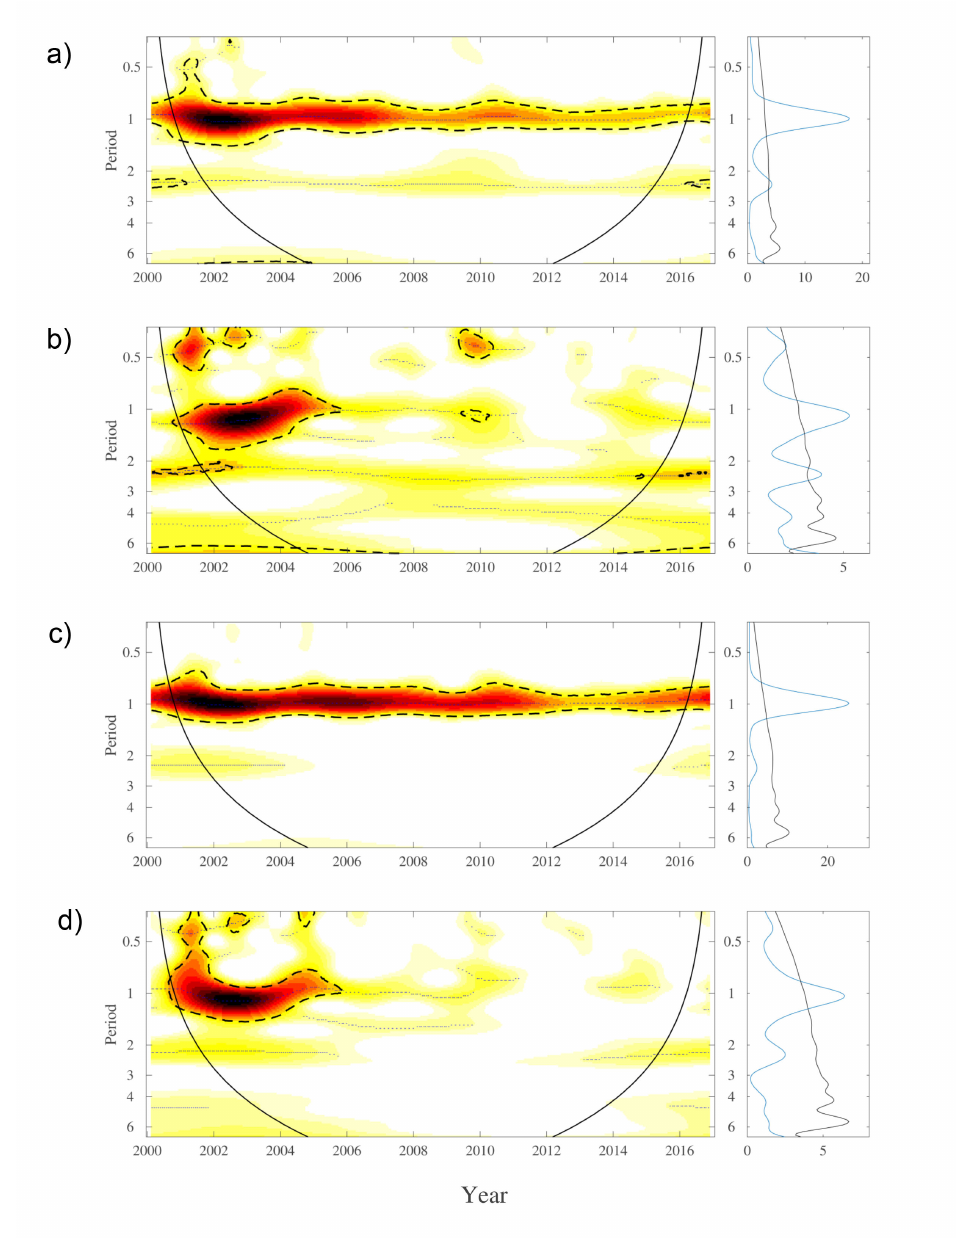
Figure 3. Wavelet Power Spectrum for ( a ) Enhanced Vegetation Index (EVI) in northern region; ( b ) Normalized Difference Vegetation Index (NDVI) in northern region; ( c ) Enhanced Vegetation Index (EVI) in southern region and ( d ) Normalized Difference Vegetation Index (NDVI) in southern region. The left panels show the local wavelet power spectrum with increasing spectrum intensity from white to dark red; black dashed lines show the 95% statistically significant areas computed with adapted bootstrapping (see [34]); the dotted lines localize the maxima of spectra in time and period; the black curve indicates the cone of influence (region not influenced by edge effects). The right panels show the global power spectrum (blue line) with its threshold value of 95% CI (black line) (see